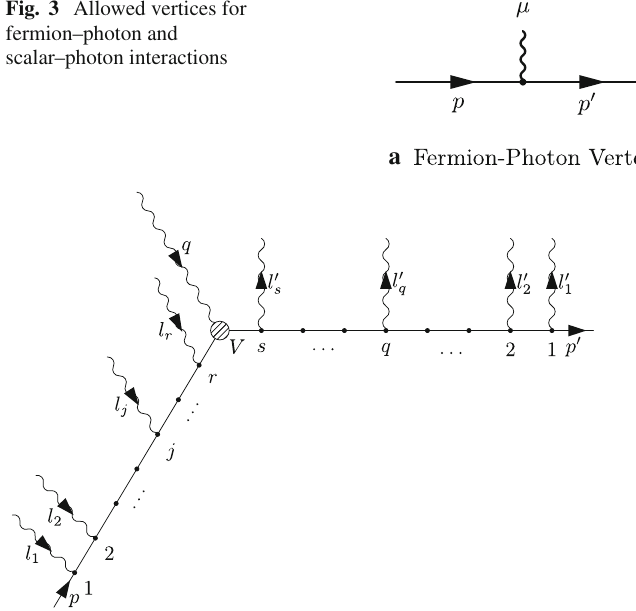
Fig. 4 Typical n th order diagram for γ ∗ f → f discussed by GY, with r ( s ) photon insertions on the p ( p (cid:6) ) leg, with r + s = m